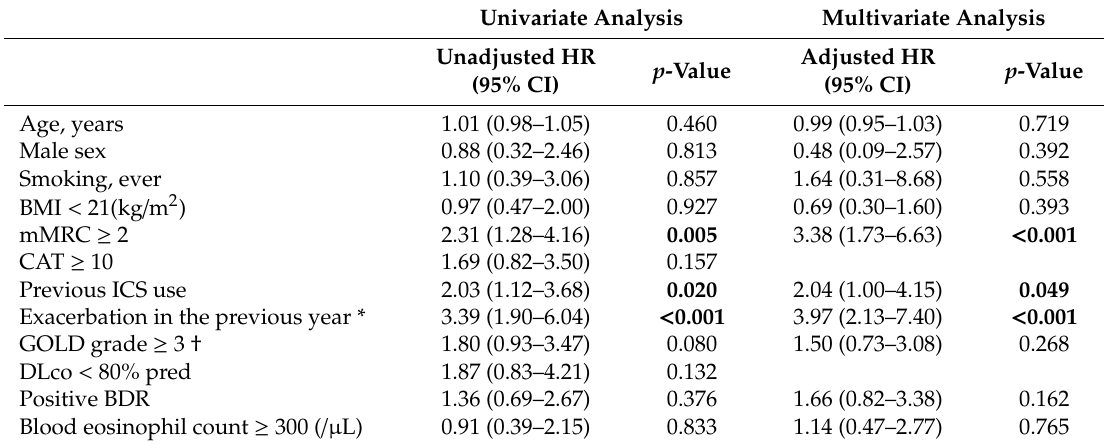
Clinical factors associated with ICS addition after LAMA / LABA fixed-dose combinations